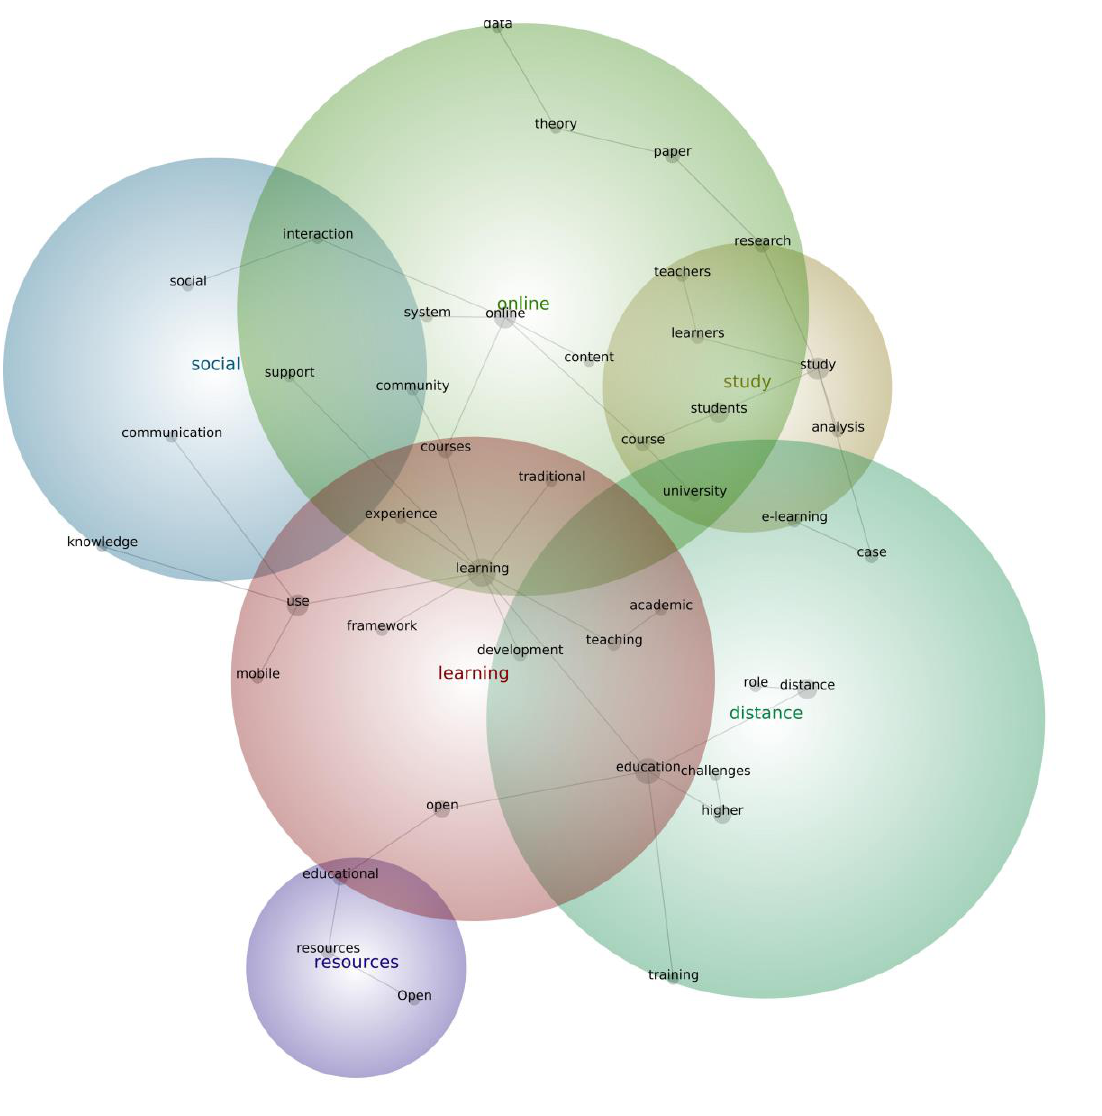
Figure 1. Concept map of overall scope of the journal IRRODL